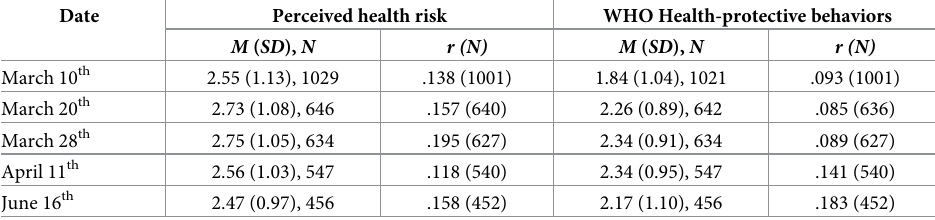
Table 2. Relationship of baseline political orientation with perceived health risk and health-protective behaviors: Study 1.